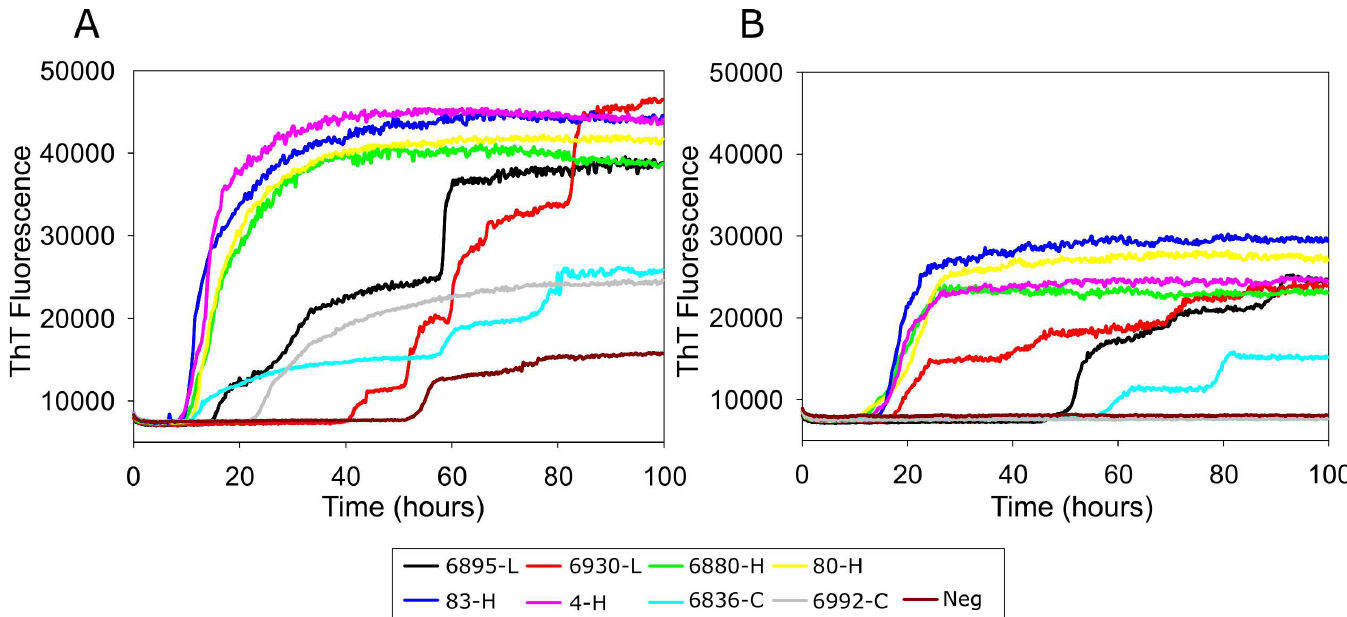
Fig 6. RT-QuIC detection of C-, L-, and H-BSE prion seeding activity using bovine prion proteins (25–241) wild type (A) and its disease associated form E211Kprotein (B). RT-QuIC reactionmixtures were seededwith 10 − 4 dilutionsof brain tissues from uninfected, C-BSE-affected (cyan and grey lines), L-BSE-affected (red and black lines) and H-BSE-affected (pink, blue, yellow, green lines) cattle. A final SDS concentration of 0.001%in combination with 300 mM NaCl was used with the substrates. Data are presentedas mean ThT fluorescence of 8 reactions conductedas 2 repeats of 4 reactions. The positive thresholdwas calculateas ~10,000relativefluorescence units of normalcattle brain